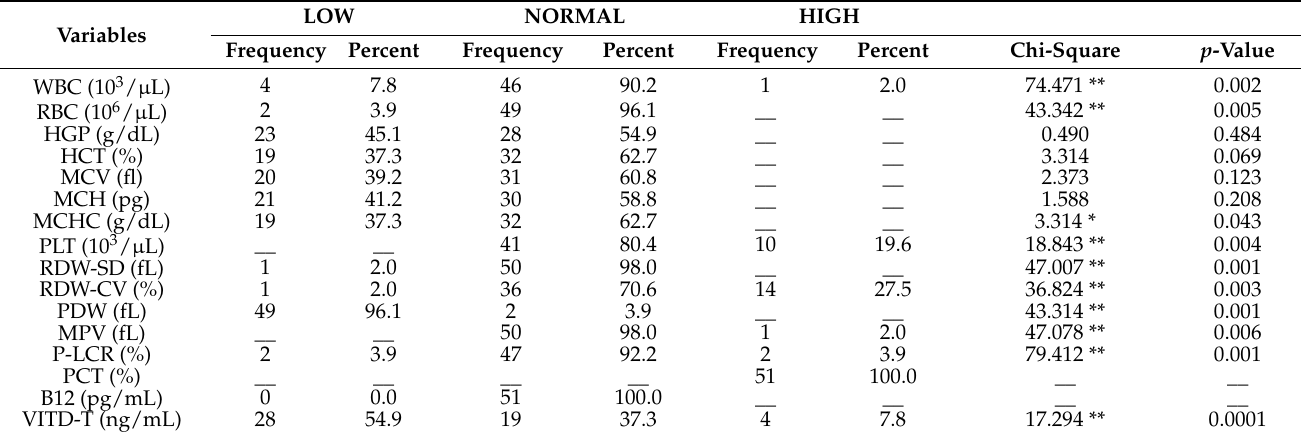
Table 3. Basic hematological parameters of females with CD ( n = 51).